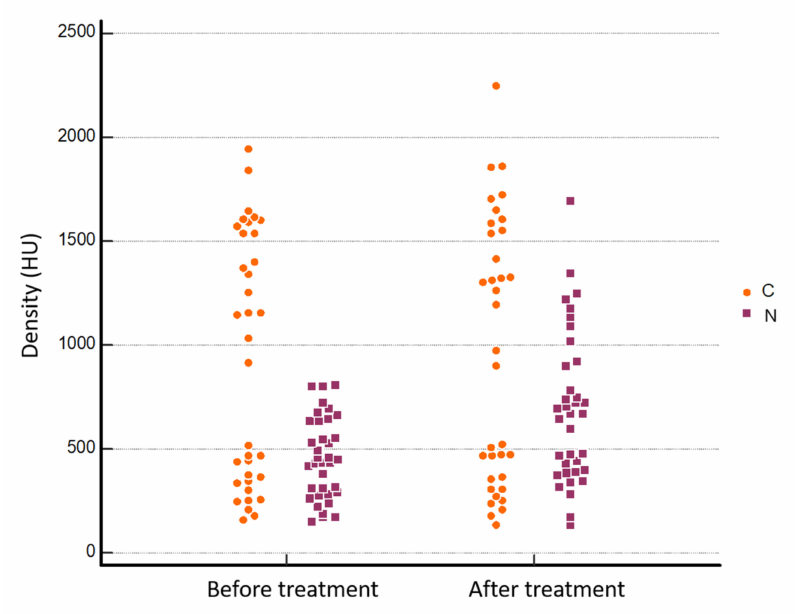
Figure 3. Bone density values at nidus level (NR) before and after MRgFUS treatment (452.75 ± 195.31 HU and 688.14 ± 362.45 HU, respectively, treatment*time interaction p < 0.001, estimated with two-factor ANOVA with repeated measures on one factor, CI = 95%). Y axis: bone density; N: nidus ROI; C: control